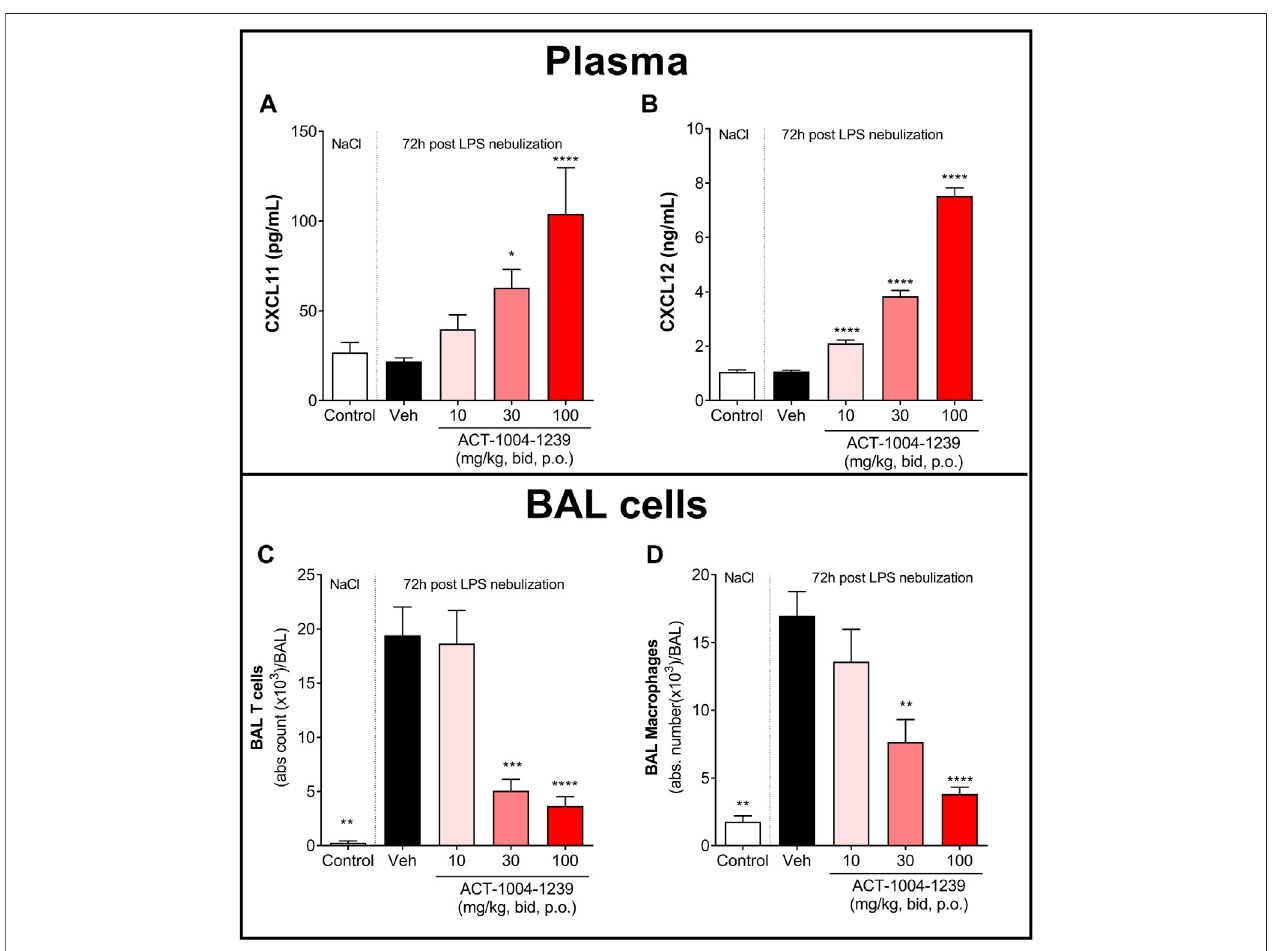
FIGURE 4 | Treatment with ACT-1004-1239 dose-dependently increases plasma CXCL11 and CXCL12 levels and reduces BAL T cell and in fl ammatory macrophage in fi ltrates in the LPS-induced ALI/ARDS model. Vehicle (Veh; black bars) or ACT-1004-1239 (10, 30, or 100 mg/kg; bars with different shades of red) was given orally, twice daily, starting 1 h prior to LPS nebulization, for a total of six administrations. Control mice (white bars) were challenged by NaCl nebulization and received vehicle administrations.PlasmaCXCL11 (A) and plasma CXCL12 levels (B) 72 h after LPS or NaCl challenge. Results are expressed asmean +SEM ( n (cid:1) 10 – 25 mice per treatment-LPS groups and n (cid:1) 4 – 5 mice for control group). * p < 0.05, **** p < 0.0001 versus vehicle-treated LPS-challenged mice, using one-way ANOVA test followed by Dunnett ’ s multiple comparisons test. Total BAL T cell (C) and BAL in fl ammatory macrophage counts (D) 72 h after LPS challenge. Results are expressed as mean ± SEM with n (cid:1) 11 – 23 mice per treatment-LPS groups and n (cid:1) 3 for controls. ** p < 0.01, *** p < 0.001, **** p < 0.0001 versus vehicle-treated LPS- challenged mice, using one-way ANOVA test followed by Dunnett ’ s multiple comparisons